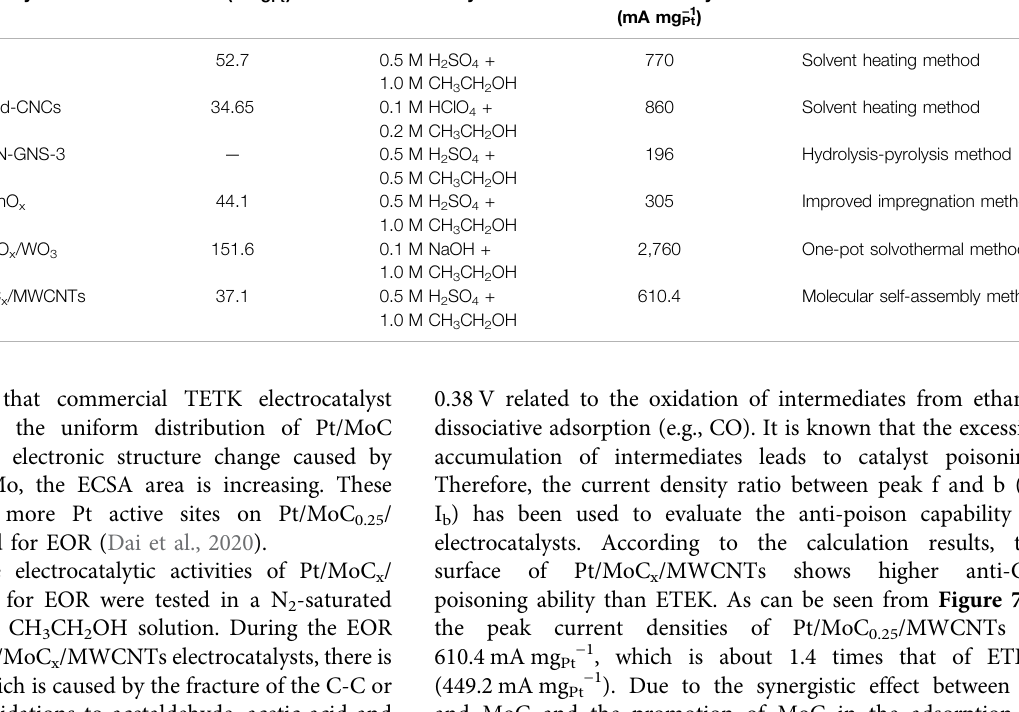
TABLE 3 | Comparisons of the EOR performance for Pt based catalysts in recently published papers.